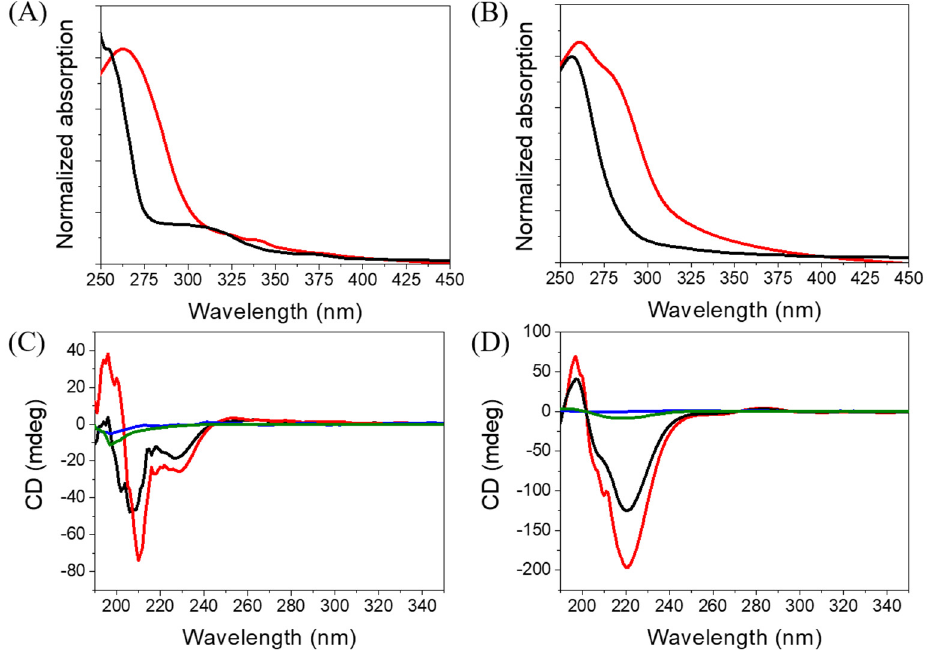
Figure 4. Absorption spectra of ( A ) Ben-IKVAV and ( B ) PFB-IKVAV at a concentration of 1 wt.% (red for water and black for methanol). CD spectra of ( C ) Ben-IKVAV and ( D ) PFB-IKVAV in water (blue for 50 μ M, green for 500 μ M, black for 1000 μ M, and red for 5000 μ M).